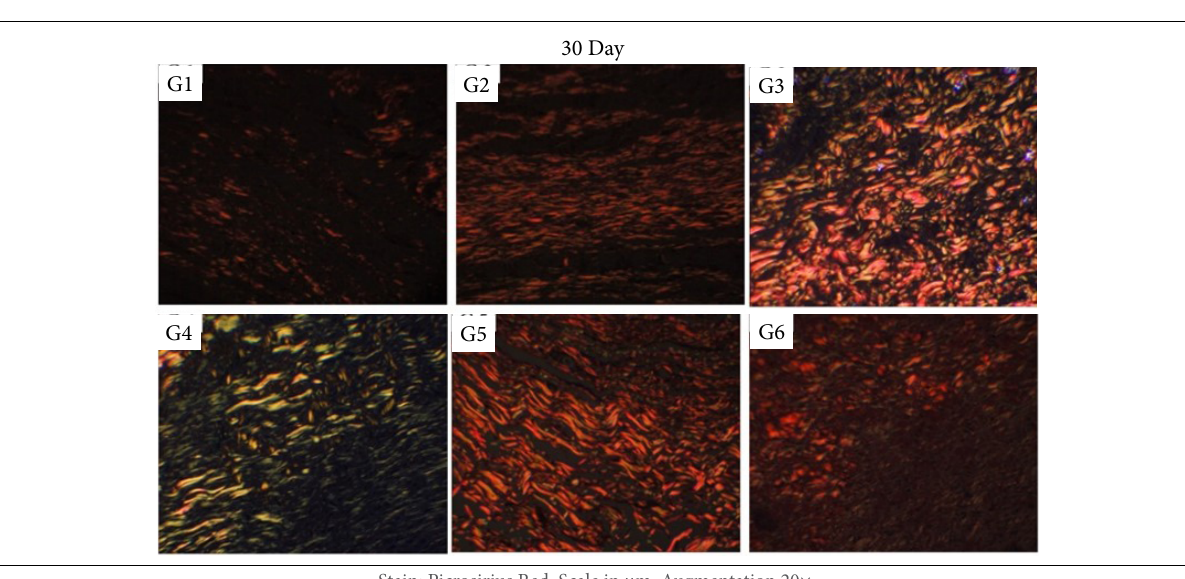
Figure 12 - Collagen fibers deposition in partial thickness burn wounds experimentally induced in Wistar rats and treated with silver-based dressings 30 DAI. Type I collagen fibers are shown in red and type III collagen fibers are shown in